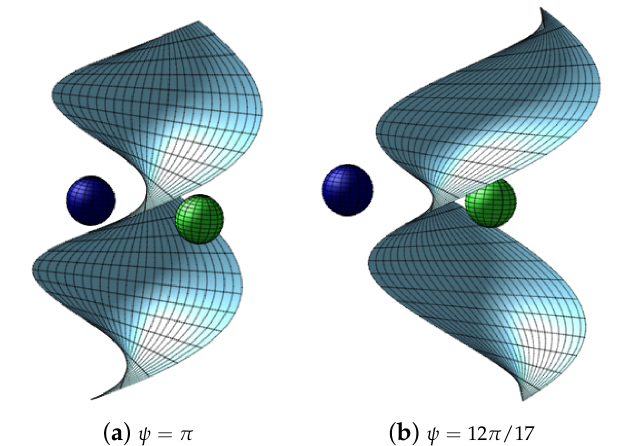
Figure 7. Three-dimensional plot of Cis molecules binding to